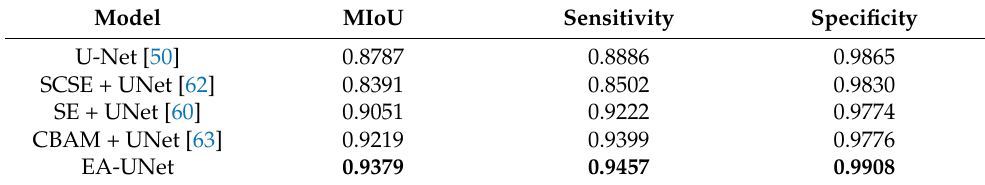
Table 2. Performance comparison between EA-UNet and other attention